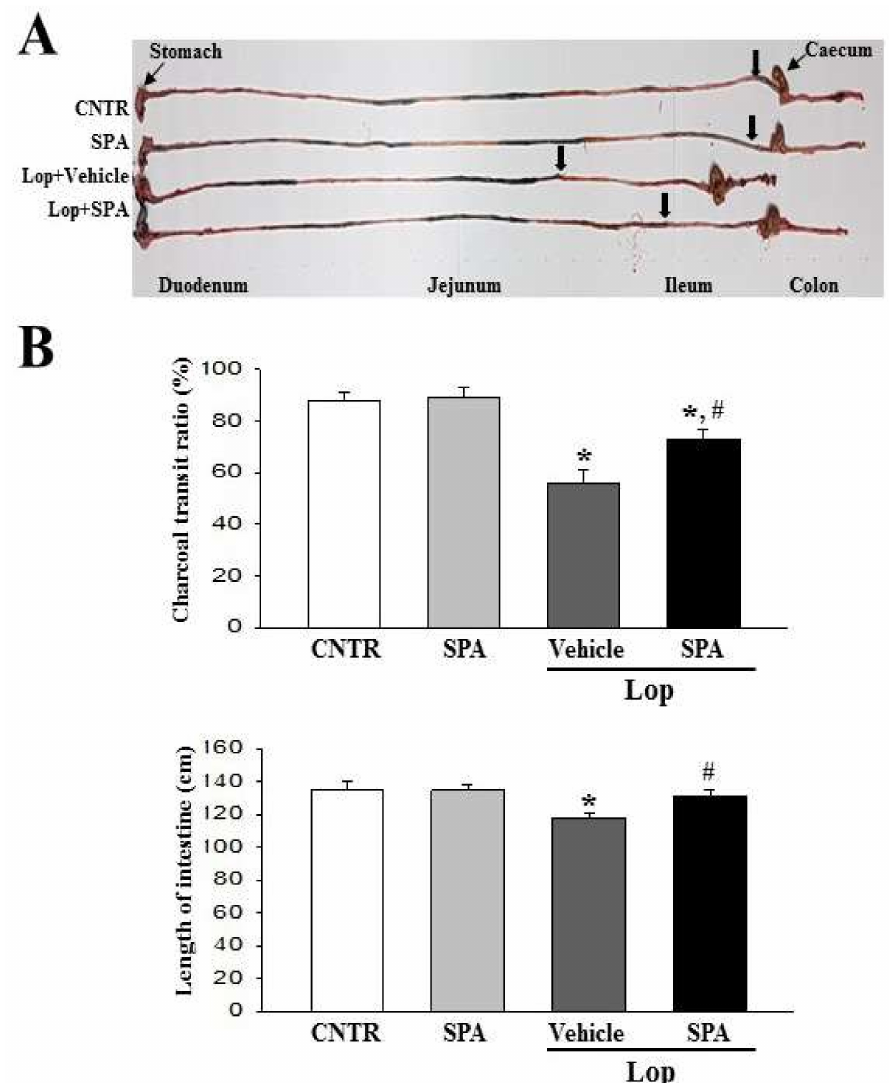
Figure 2. The gastrointestinal transit ratio and the intestine length: ( A ) An actual image of the charcoal meal transit and the intestine. The total intestinal tract was excised from a rat of the subset groups treated with charcoal meal powder. Their morphology was observed using a digital camera. The arrows indicate the position of the charcoal meal. ( B ) The transit ratio of the charcoal meal and the length of intestine: The total distance travelled by the charcoal meal from the pylorus was measured. The charcoal meal transit ratio was then calculated using the total length of the intestine and the distance of the charcoal meal. Six to seven rats per group were used in the gastrointestinal transit ratio test, and the charcoal meal transit distance and intestine length were measured in triplicate. The data are reported as the mean ± SD. * p < 0.05 compared to the CNTR group. # p < 0.05 compared to